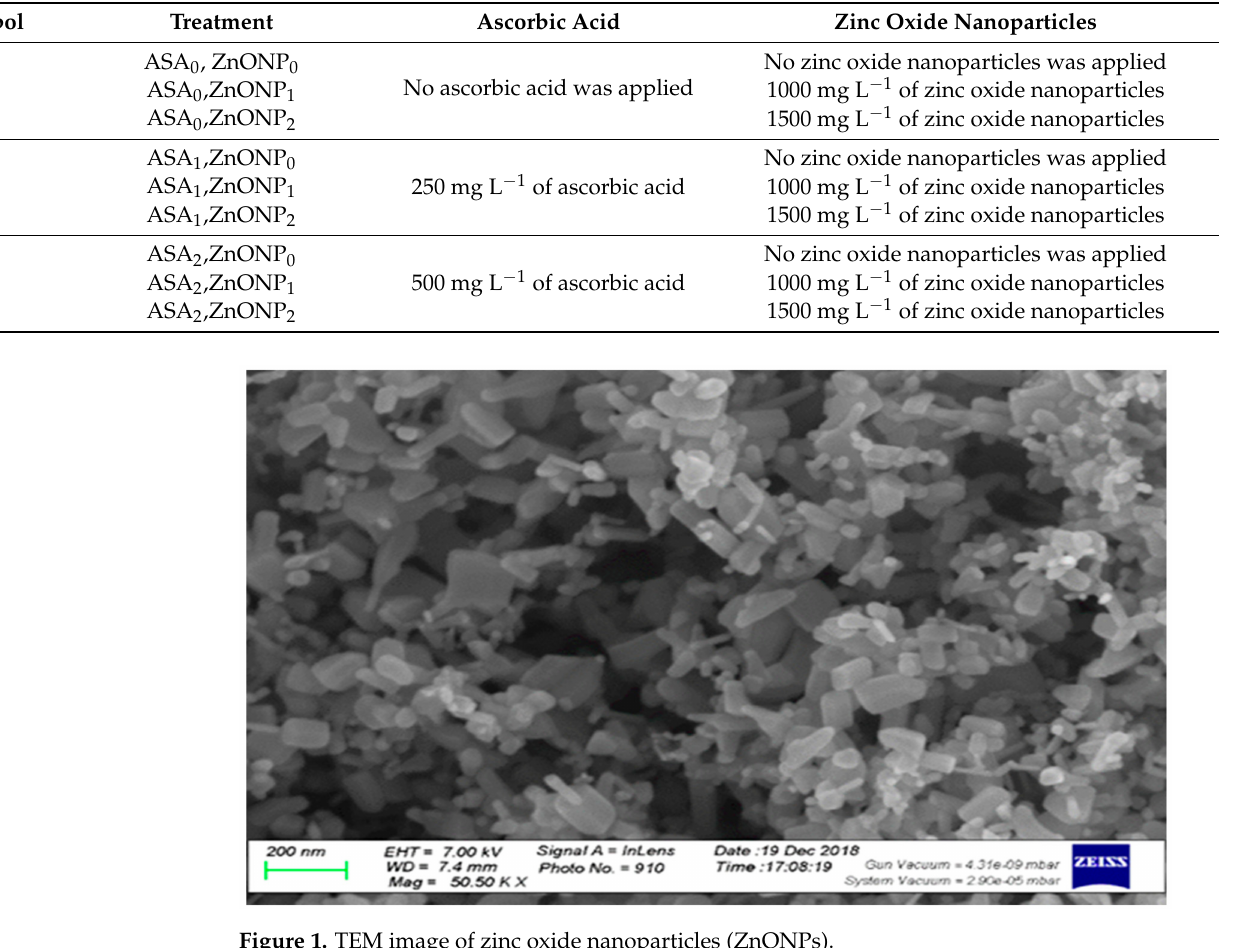
Figure 1. TEM image of zinc oxide nanoparticles